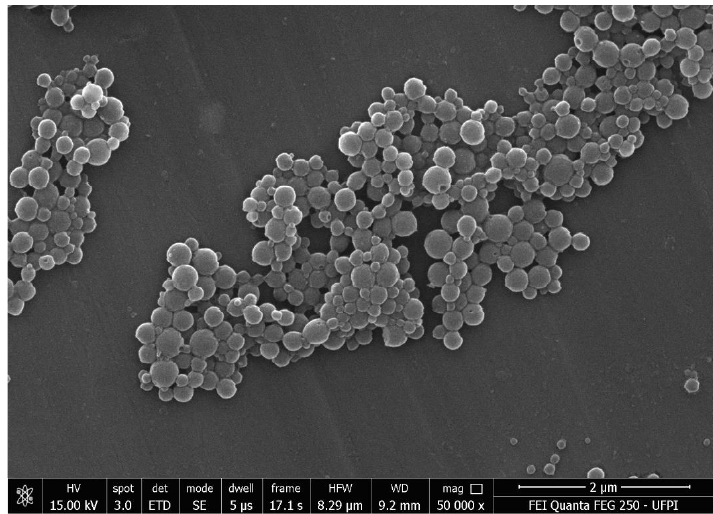
Figure 5. Scanning electron microscopy (SEM) of NP-ZN-MSZ.